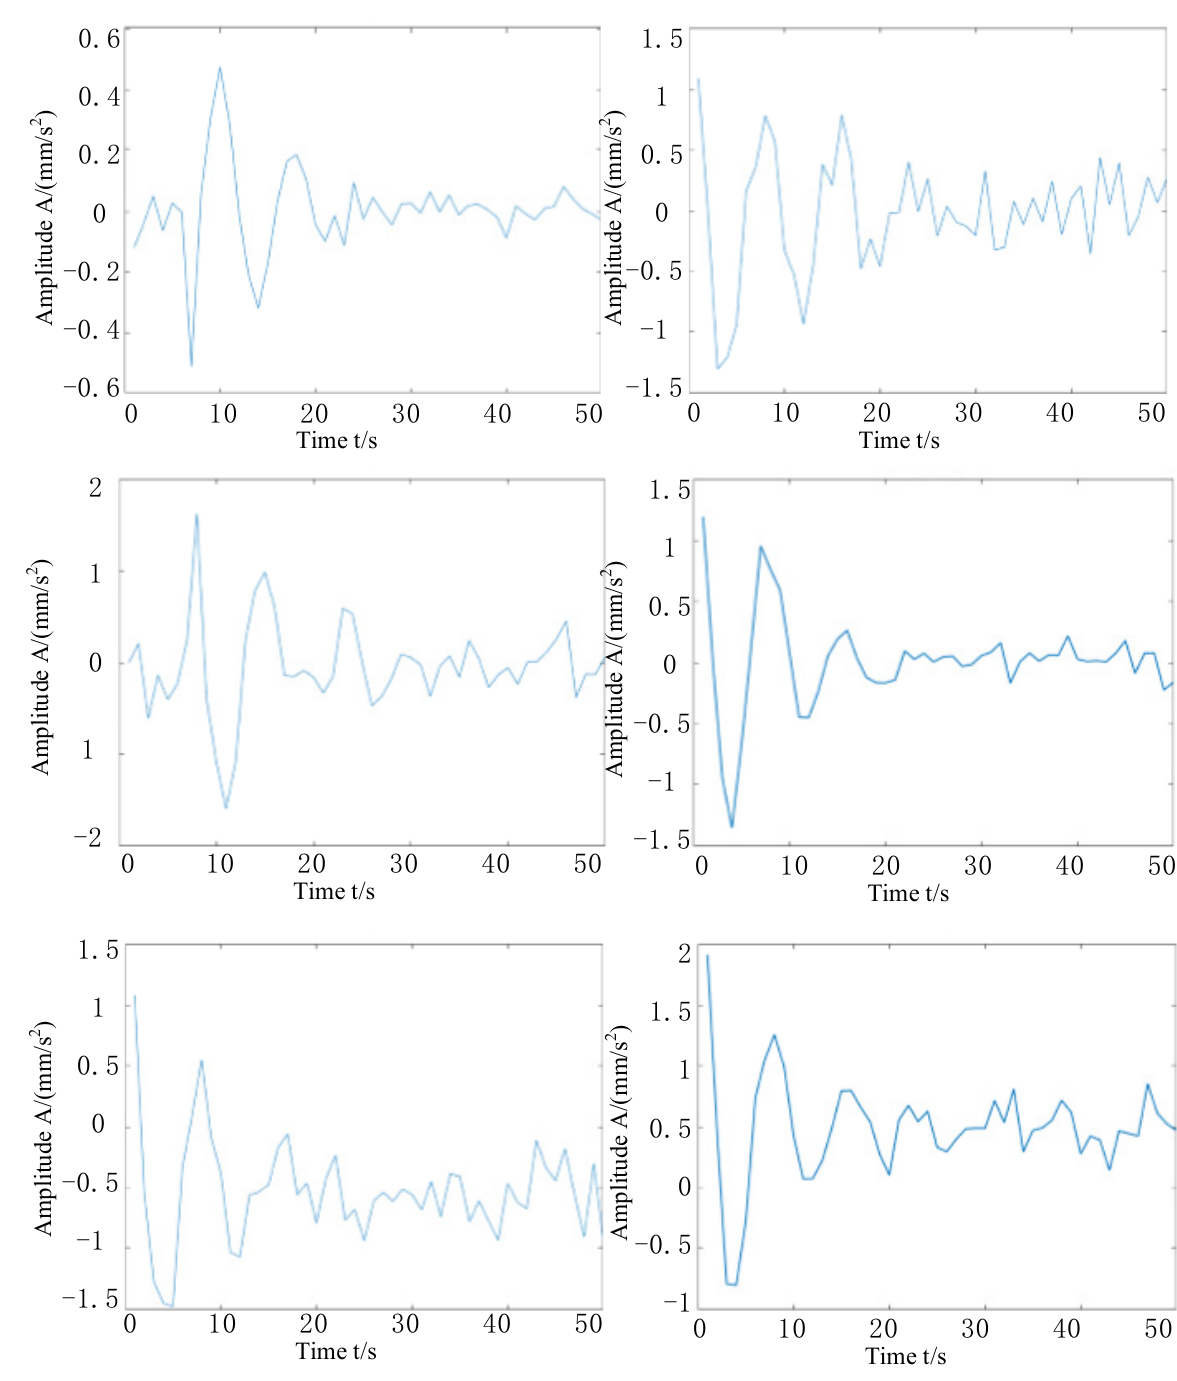
Figure 11. Six atoms randomly selected from the learn dictionary.